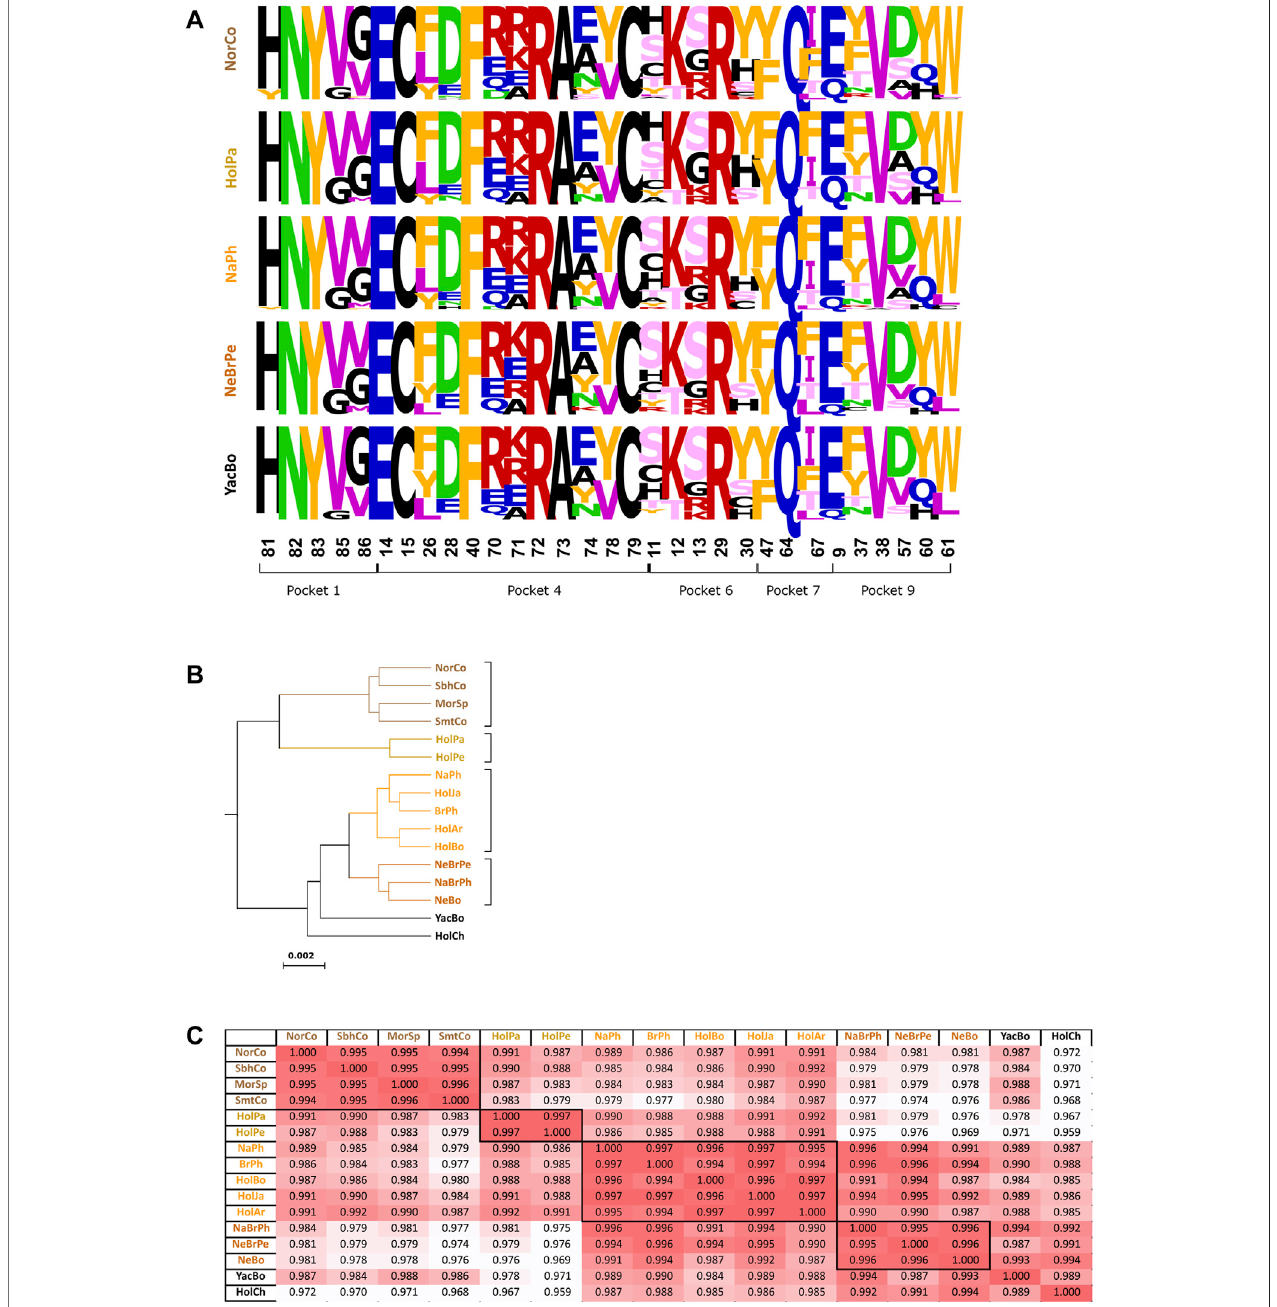
FIGURE 3 | Peptide binding region similarity and correlation. (A) BoLA-DRB3 allele peptide binding region (PBR) logos representative of each cattle population group.ConservativeaachangesaccordingtotheBLOSUM62substitutionmatrixareshowninthesamecolor;differentcolorsindicatenon-conservativechanges:FYW (yellow), MILV (purple), RK (red), EQ (blue), DN (green), ST (pink), HCPAG (black). PBR Pockets and their aa forming positions are indicated below the logos. (B) Clustering analysis based on correlation analysis. (C) Pearson correlation coef fi cient matrix for populations based on PBR sequence variability. Population group colors are the same for panels (A,B,C)